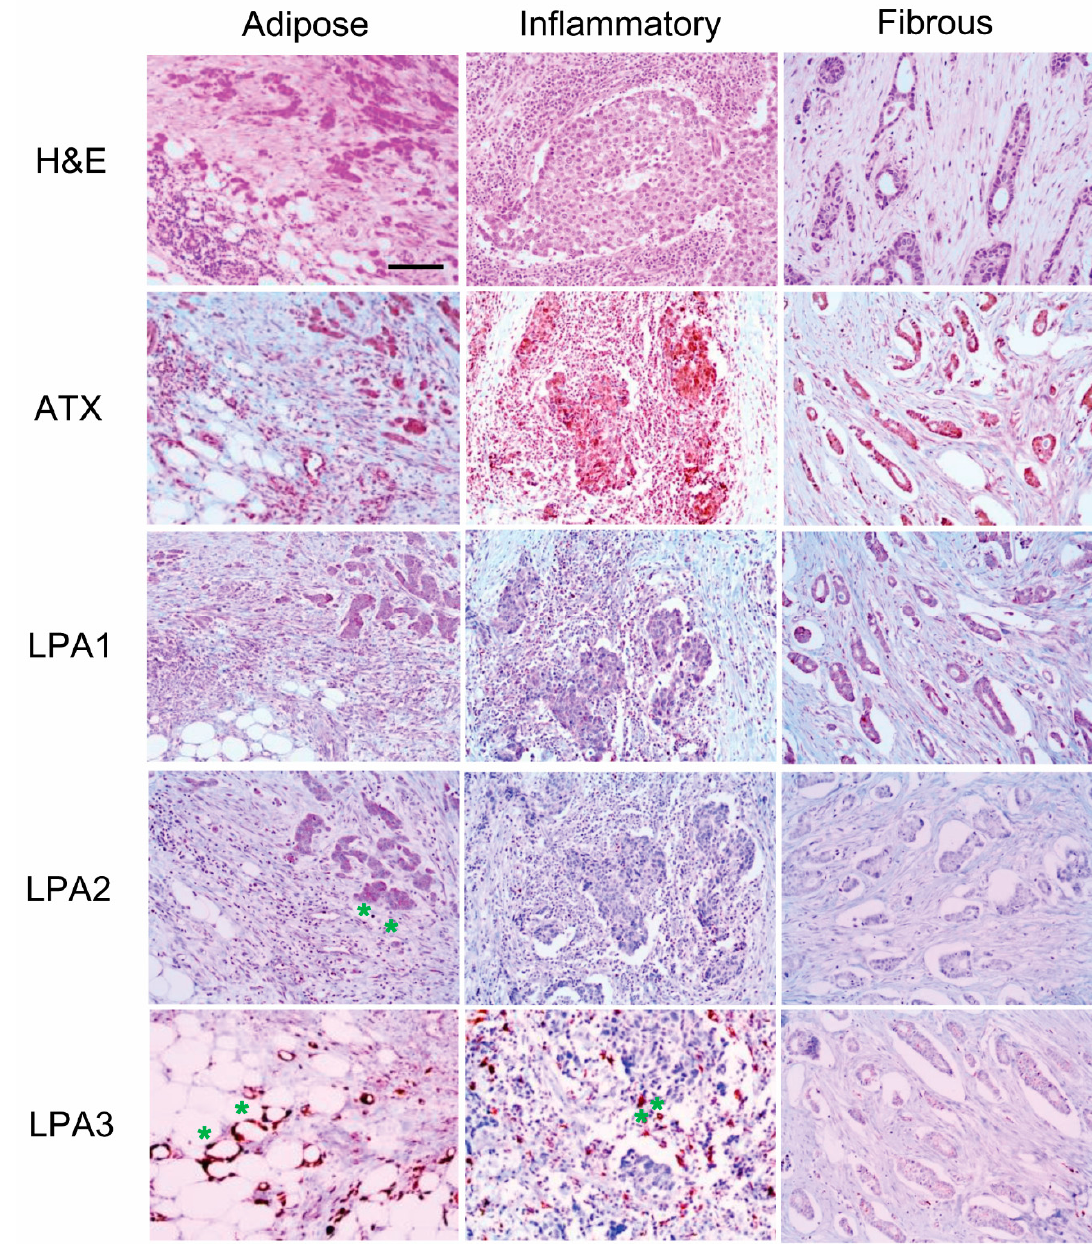
Figure 1. Expression of ATX-LPA signaling-related proteins according to breast cancer stroma type in immunohistochemical stain. High expression of LPA2 in cancer cells is observed in the breast cancer with adipose stroma (*), and LPA3 is highly expressed in the stromal cell compartment of breast cancer with adipose stroma and breast cancer with inflammatory stroma (*). LPA3 positive stromal cells are immune cells like macrophages. H&E, hematoxylin and eosin. Scale bar represents 200 μ m.